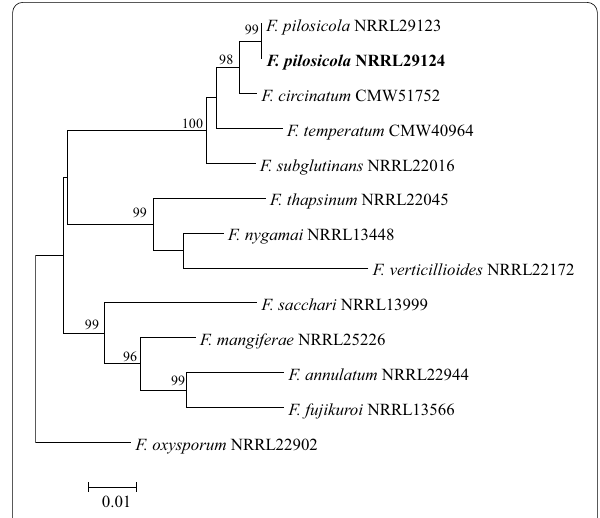
Fig. 1 Maximum likelihood tree based on the partial gene sequences of translation elongation factor 1‑α and β‑tubulin (Herron et al. 2015; Wingfield et al. 2015, 2018). Sequence alignments were assembled with MAFFT v 7.472 (Katoh et al. 2019). The program jModelTest v 2.1.10 (Darribo et al. 2012) was used to determine the best‑fit substitution model (TIM2 G substitution model) with gamma + correction (Tavare 1986). A maximum likelihood (ML) phylogenetic analysis was performed using PhyML v 3.1 (Guindon et al. 2010). Values at branch nodes are the bootstrapping confidence values with those 85% shown. The F. pilosicola isolate sequenced in this study ≥ was indicated in